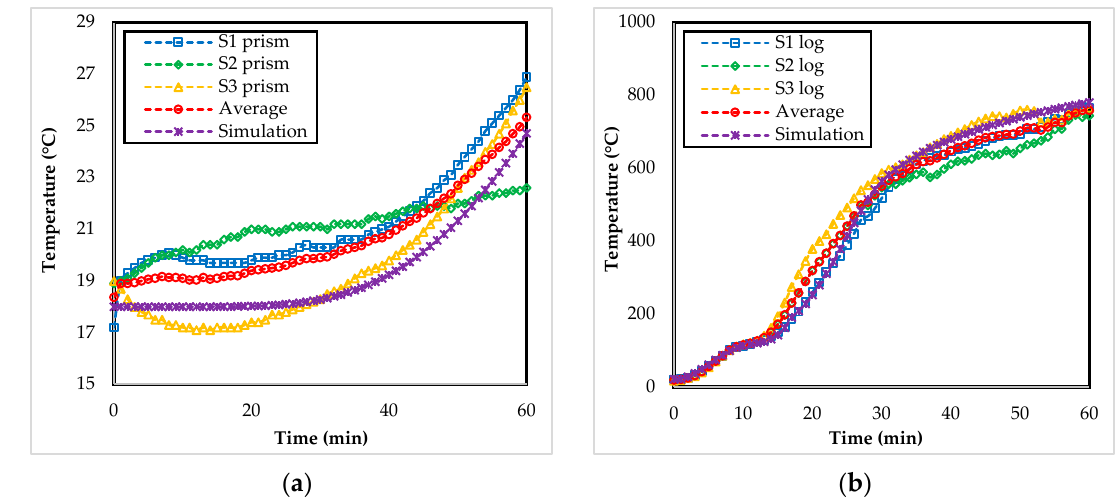
Figure 8. Temperature profile: ( a ) depth of 100 mm (prisms); ( b ) depth of 20 mm (logs).